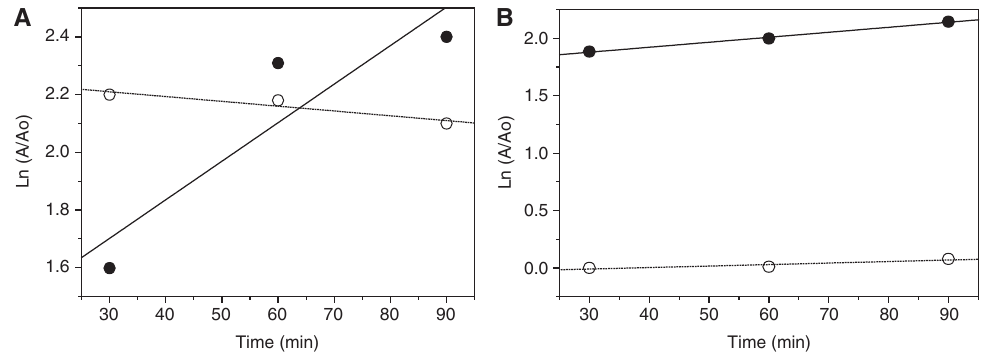
/G and (•) CdS-TiO /G as a photocatalyst under irradiation of (A) 380 nm 2 2